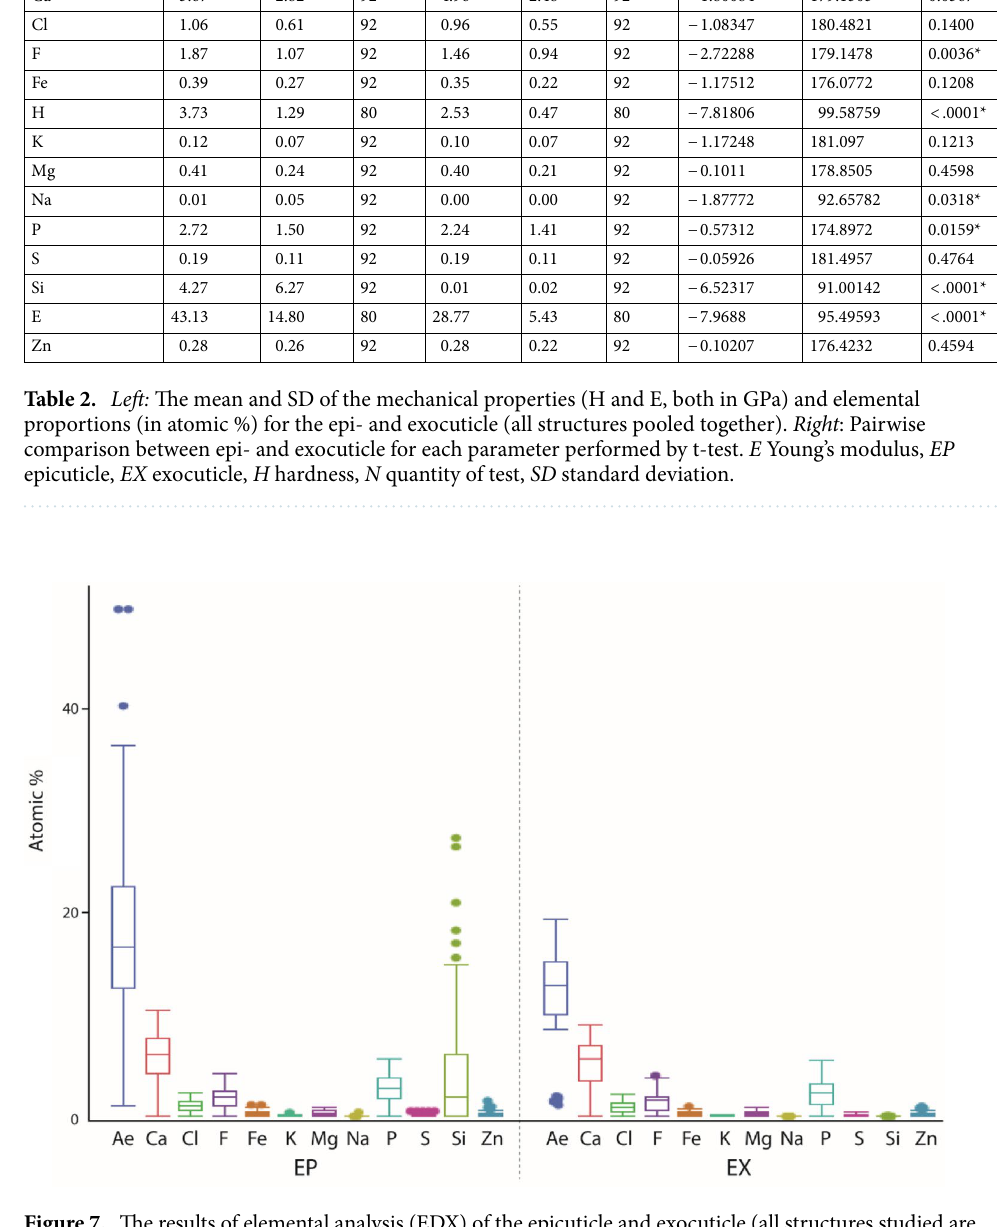
and E, Ca and Cl, Ca and A, H and Si, Si and E – high positive correlations (r = 0.75–0.87). Ae and Cl, Ae and Cl, Ae and F, Ae and Fe, Ae and Zn, Ca and F, Ca and Fe, Ca and Zn, Cl and F, Cl and P, F and Mg, F and P, F and Zn, Fe and Zn, K and P showed moderate positive correlations (r = 0.50–0.69). All other parameter pairs showed low or negligible correlations. When plotting the Young’s modulus against the proportion of elements, the positive relationship becomes visible (between E and Ae, E and Si, E and Ca, E and F, E and P) (Supplementary Fig. 6). When, however, these values are sorted to either epi- or to exocuticle, we could detect that this relationship is especially pronounced for the epicuticle, whereas we could not determine such a relationship for the exocuticle (Fig. 8).